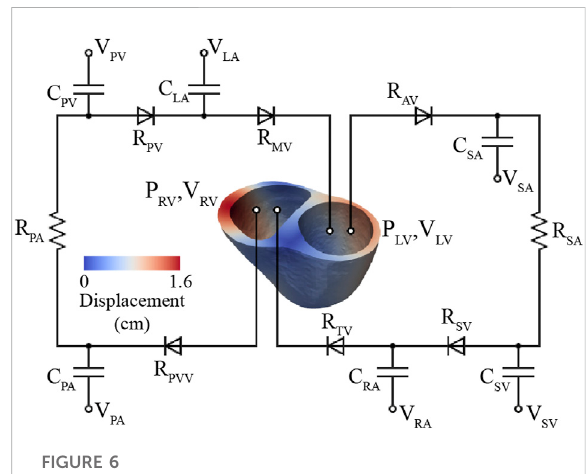
FIGURE 6 High-resolution (3D) ventricular model coupled to a 0D closed-loop circulatory model, which includes the systemic and pulmonary arteries, venous systems, atria, and